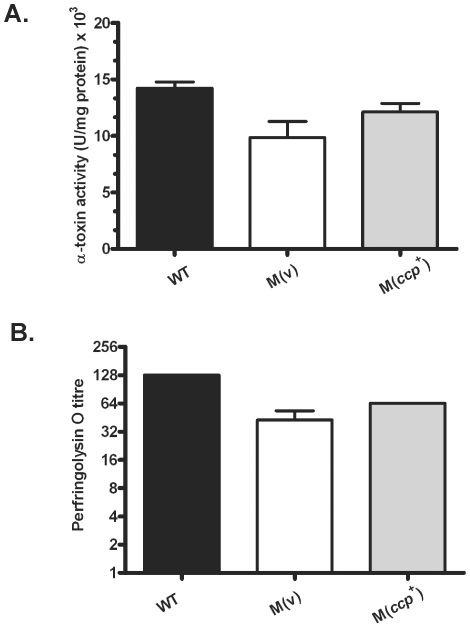
α-toxin and perfringolysin O activity in culture supernatants of isogenic strains.Mid-exponential phase culture supernatants from the wild-type strain (WT), a ccp mutant carrying the vector plasmid pJIR750, M(v), and the ccp mutant carrying the ccp+ complementation plasmid pJIR3680, M(ccp+), were either concentrated 5-fold or used undiluted to assay for α-toxin (A) or perfringolysin O activity (B), respectively (n = 3). Error bars represent S.E.M.